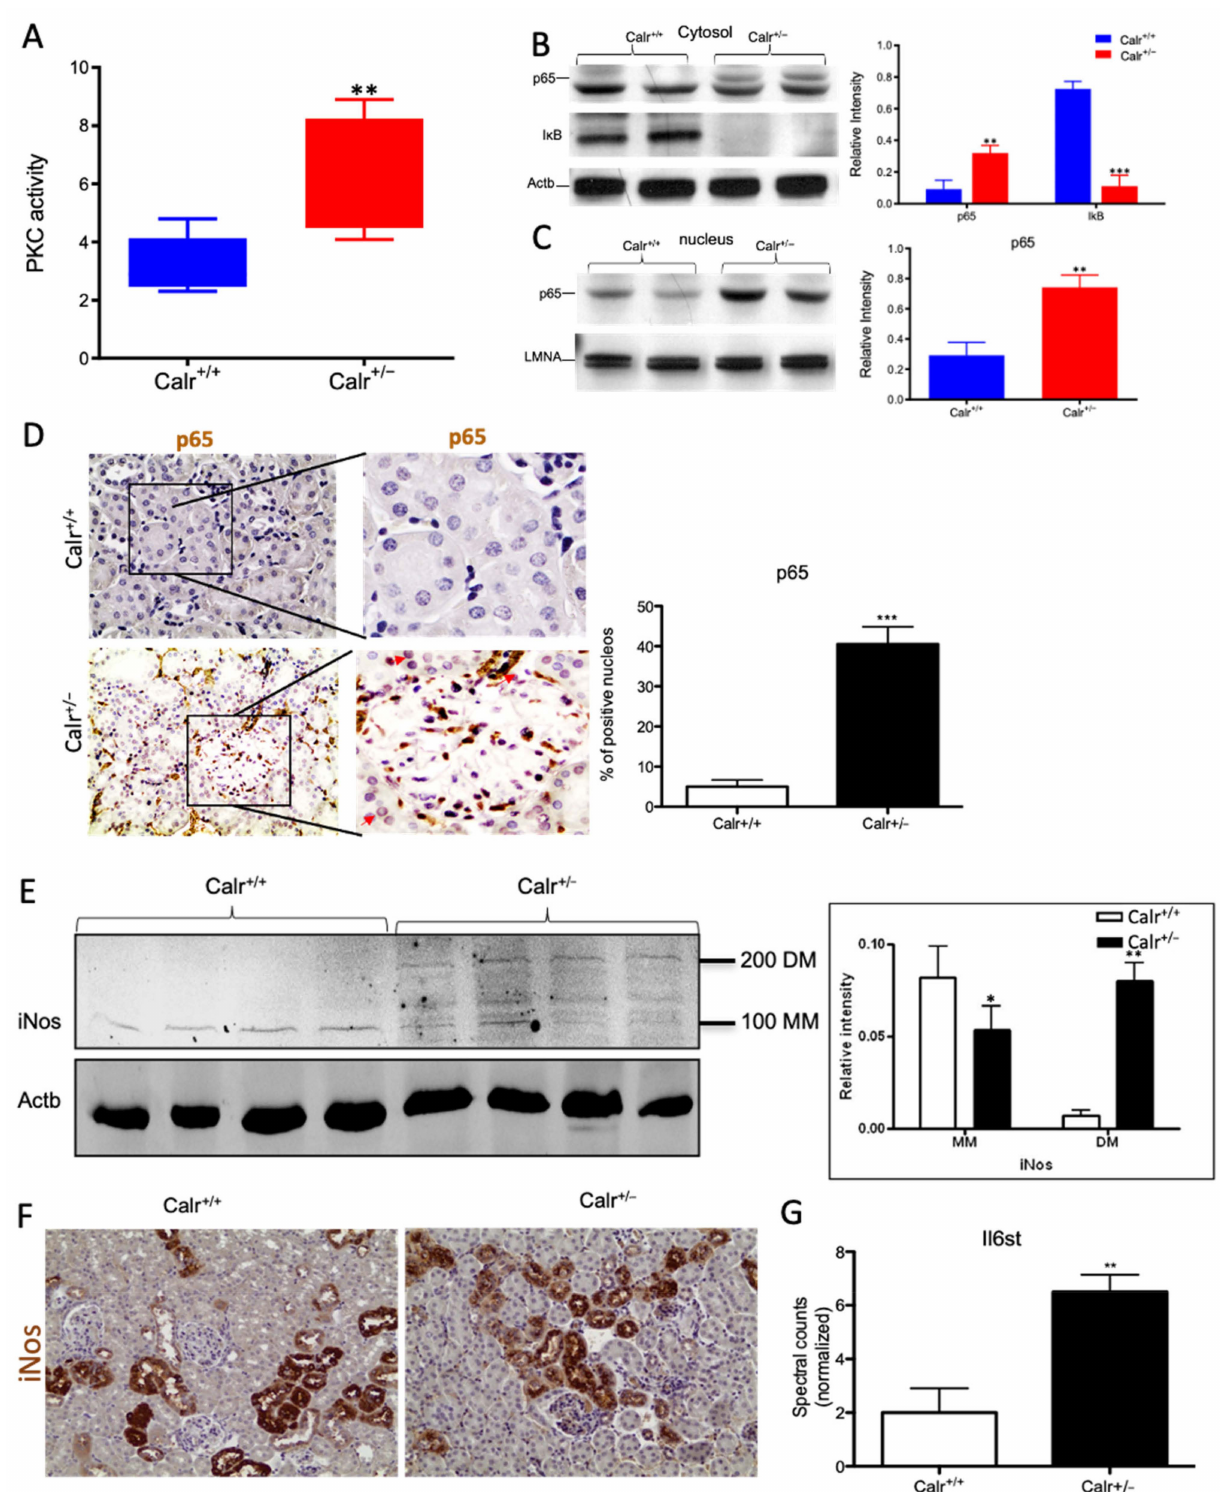
Figure 8. Chronic increased cytosolic calcium level results in activation of PKC and NF- κ B pathway in Calr +/ − kidney. ( A ): Activity assay demonstrated significant activation of PKC in Calr +/ − mouse kidney because of alteration in cytosolic calcium concentration. ( B ): Western blot analysis of protein extracts from Calr +/+ and Calr +/ − kidneys showed an activation of NF- κ B pathway as evidenced by up-regulation of p65 in heterozygous kidney and down-regulation of the pathway inhibitor IkB. ( C , D ): The nuclear translocation of p65 confirmed the activation of NF- κ B pathway, the nuclear protein Lamin A/C was used as control. ( E ): Western blot analysis of iNos was performed for